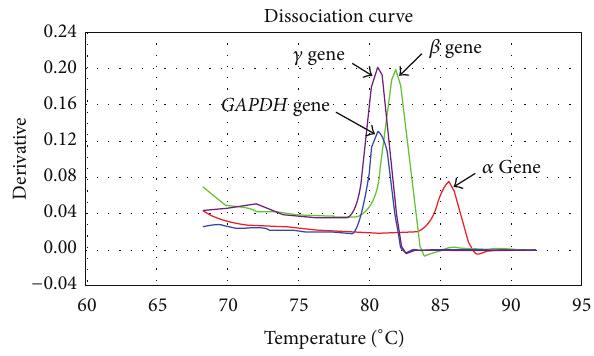
Figure 3: Dissociation curve for different genes.